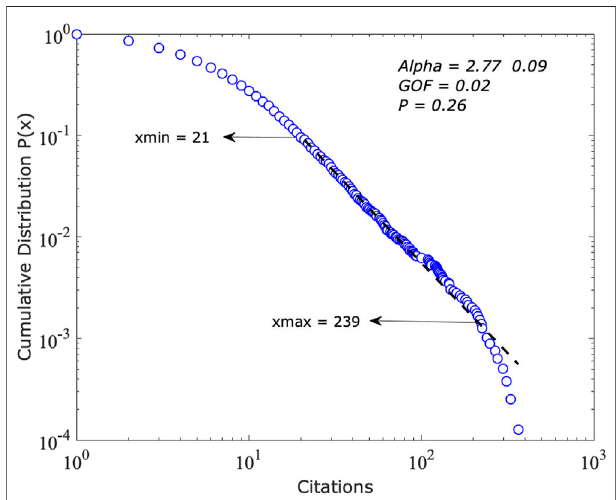
FIGURE 2 | The cumulative distribution function of citations of the power-law model; x (cid:2) citations.